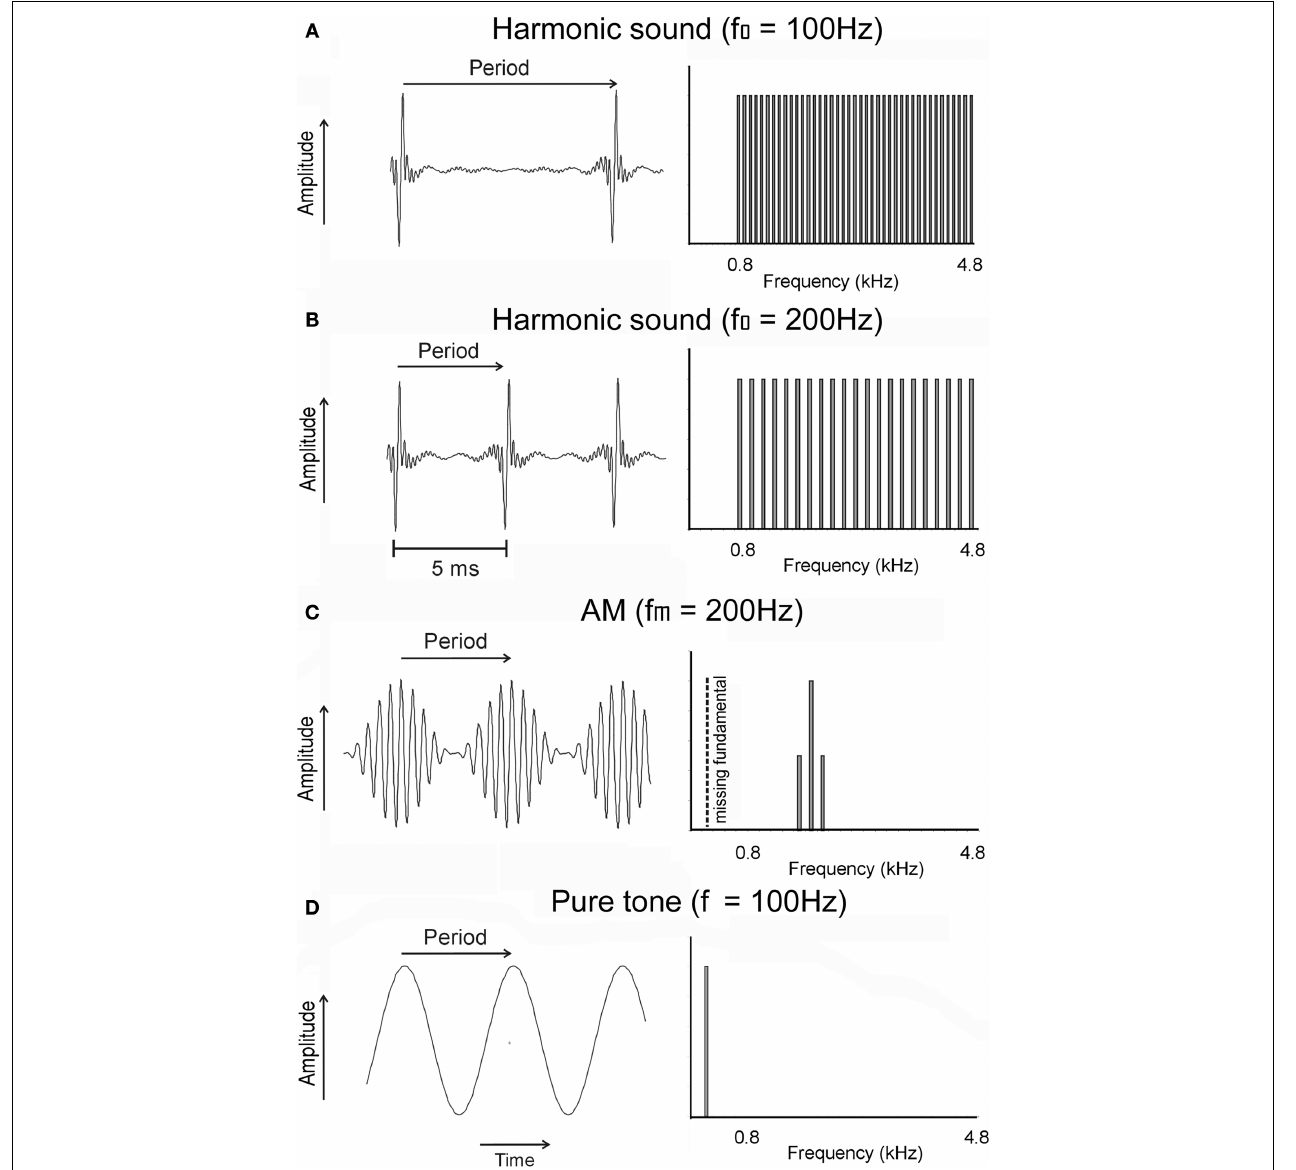
FIGURE 1 | Temporal (left) and spectral (right) representation of examples of signals used to determine the layout of frequency and periodicity maps. (A) A harmonic sound composed of periodic pulses with a periodicity of 100 Hz, corresponding to a repetition period of 10 ms. The signal extends from 0.8 to 4.8 kHz; the fundamental frequency of 100 Hz and the harmonics below 800 Hz were fi ltered out. (B) The same stimulus as in (A) , but with a fundamental frequency of 200 Hz, corresponding to a period of 5 ms. Other harmonic sounds